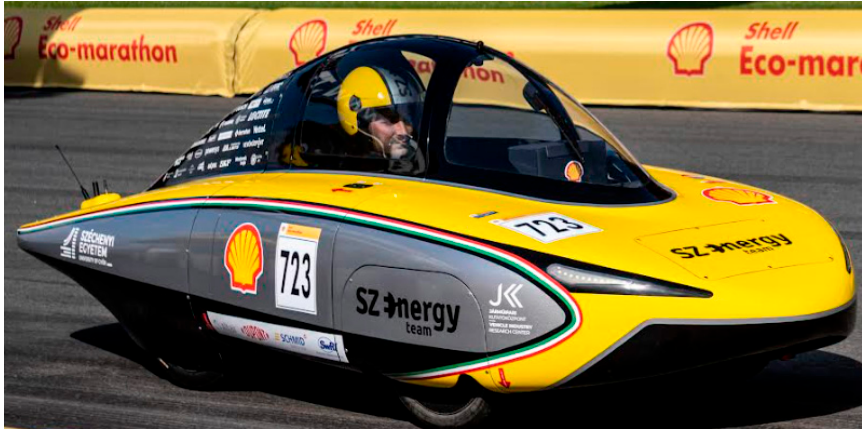
Figure 1. SZEmission on the track at Assen SEM 2022.